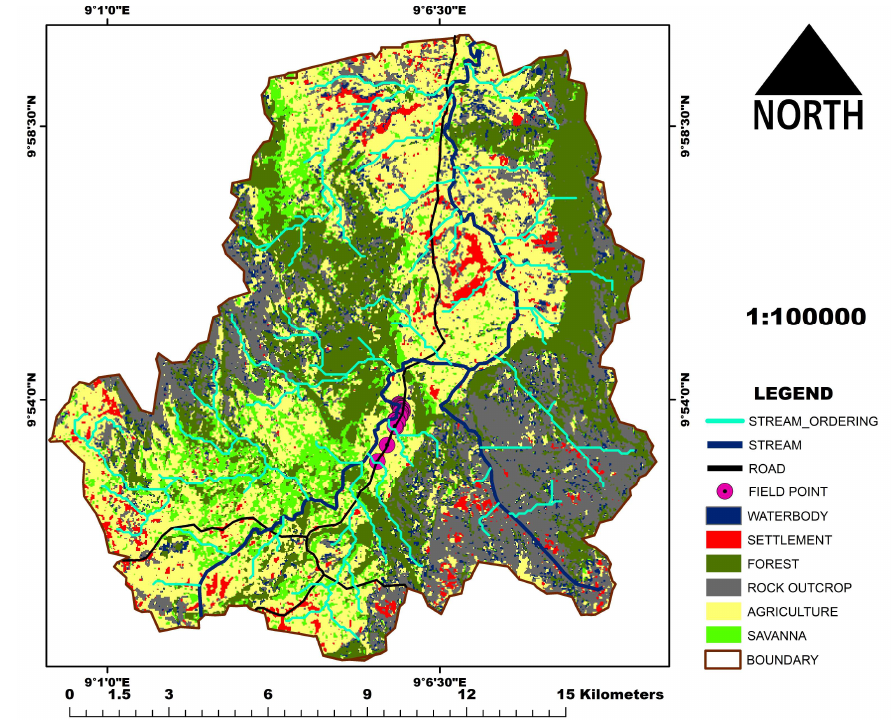
Figure 2. The land cover of Koromi catchment.